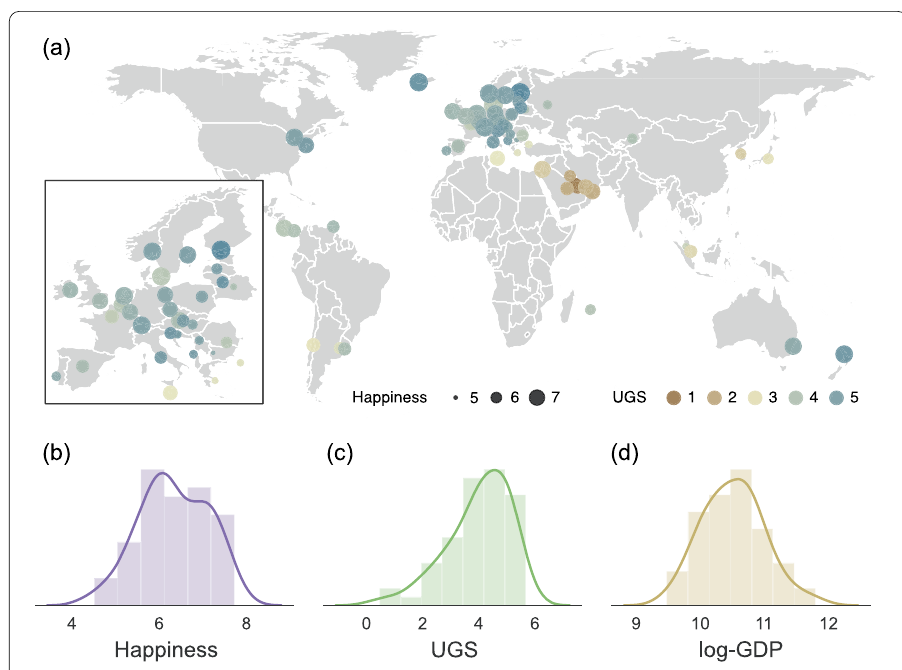
Figure 1 The distributions of urban green space and happiness over the world. ( a ) The map of urban green space and happiness in 60 developed countries. The size and color of circles represent the level of happiness and urban green space in a country, respectively. The markers are placed on the most populated cities of each country. ( b )–( d ) The histograms of ( b ) happiness, ( c ) urban green space (UGS) and ( d ) logarithmic GDP per capita (log-GDP). We use the logarithm of the total NDVI per capita as an indicator of urban green space, and the logarithm of GDP per capita as a measure of wealth